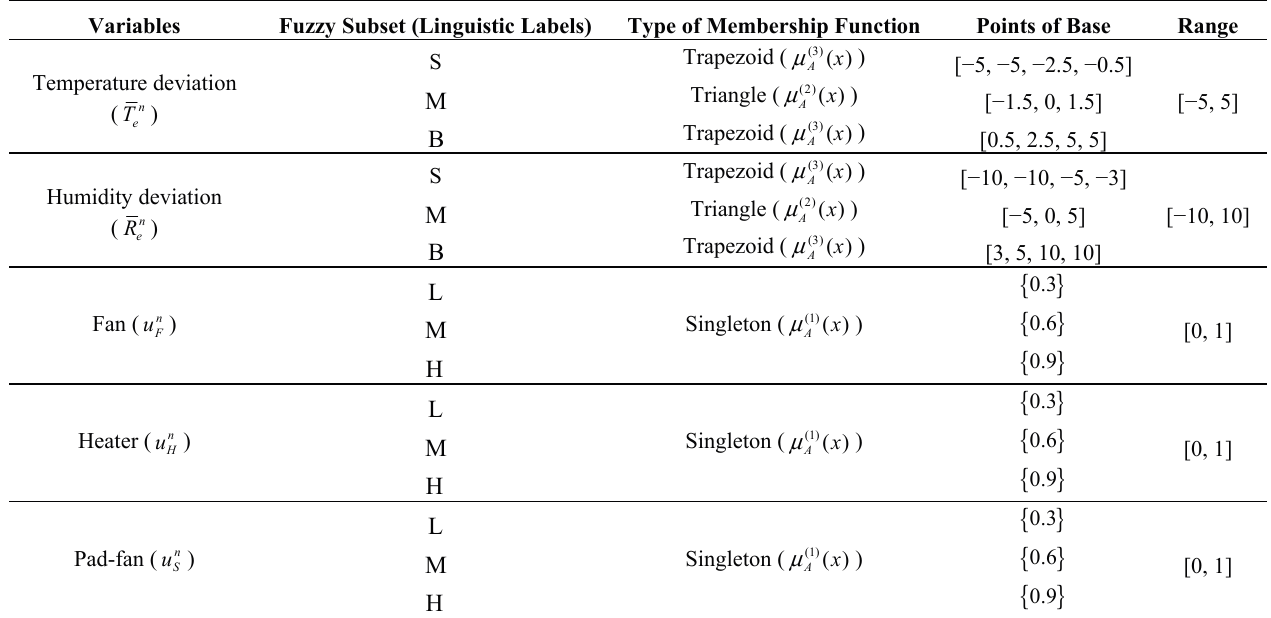
Table 1. Fuzzification parameter settings and different type of membership function